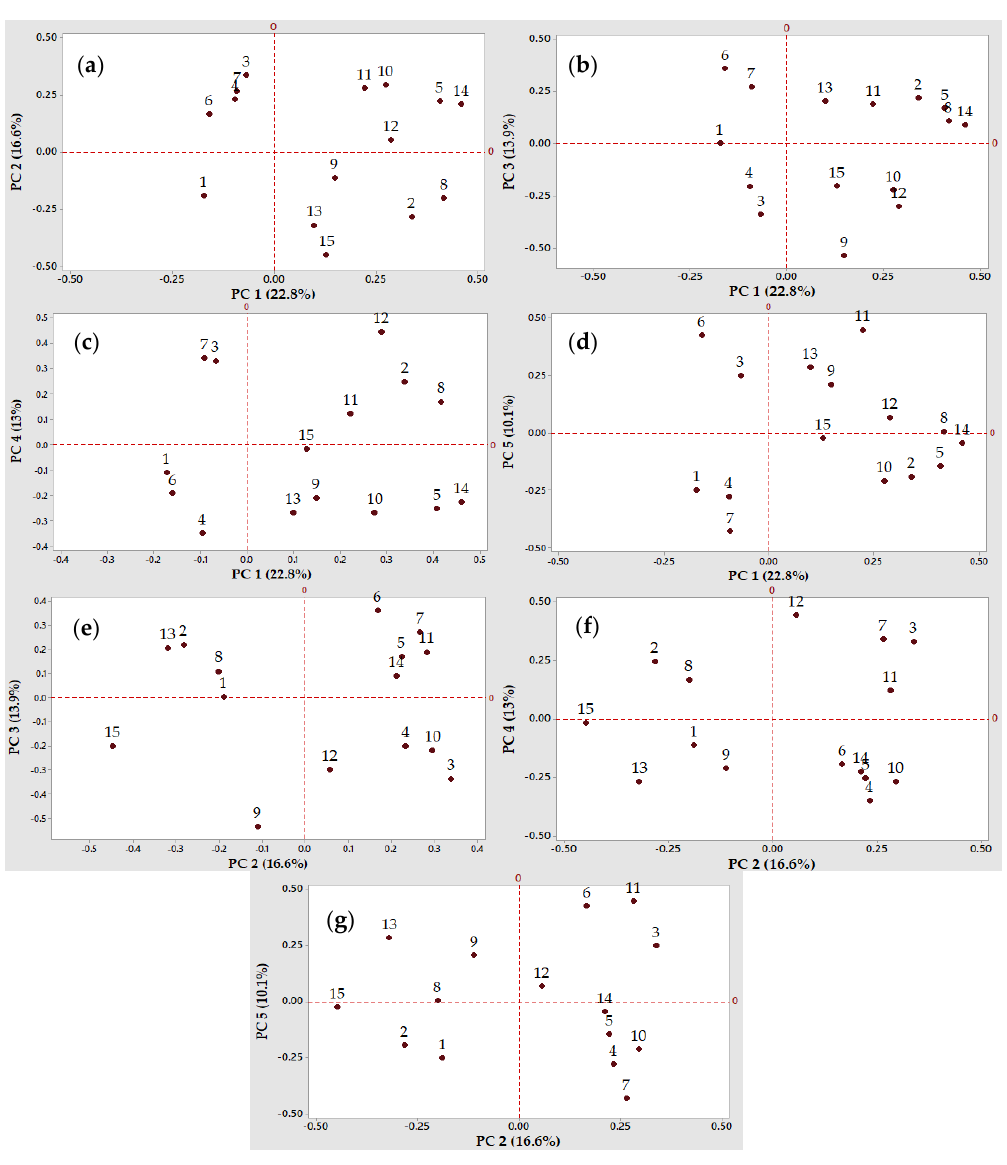
Figure 2. Two-dimensional loading plots of the Principal Component Analysis (PCA). Projection of the variables into the principal component (PC) 1 to 5 (cumulative percent variability in parentheses): ( a ) PC 1 and PC 2 (39.4%); ( b ) PC 1 and PC 3 (36.7%); ( c ) PC 1 and PC 4 (35.8%); ( d ) PC 1 and PC 5 (32.9%); ( e ) PC 2 and PC 3 (30.5%); ( f ) PC 2 and PC 4 (29.4%); and ( g ) PC 2 and PC 5 (26.7%). The numbers in the plots refer to the identification of variables.